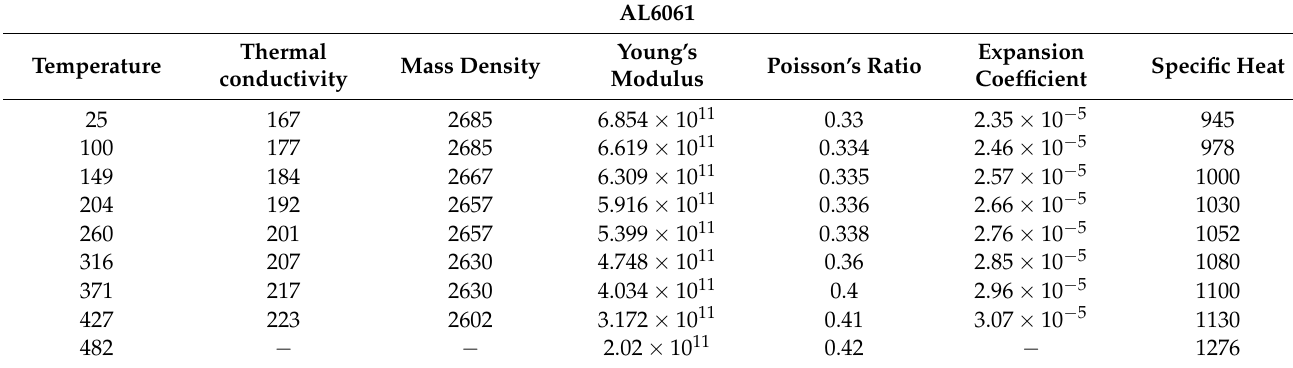
Table 3. Temperature-dependent Young’s modulus, specific heat, Poisson ratio, thermal conductivity, expansion coefficient, and mass density for AL6061 [43].